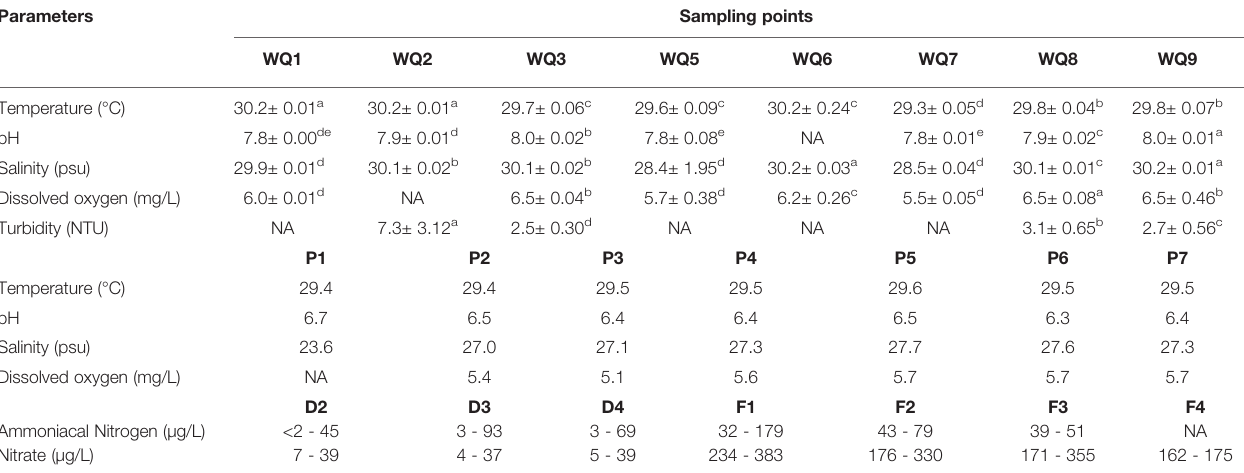
TABLE 2 | Physio-chemical properties of water sampling sites (existing and proposed site) at Kukup Strait, Johor, Malaysia.